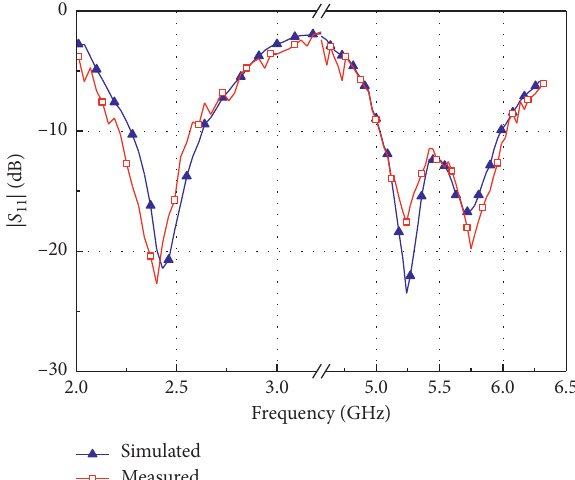
Figure 11: Simulated and measured S-parameters.